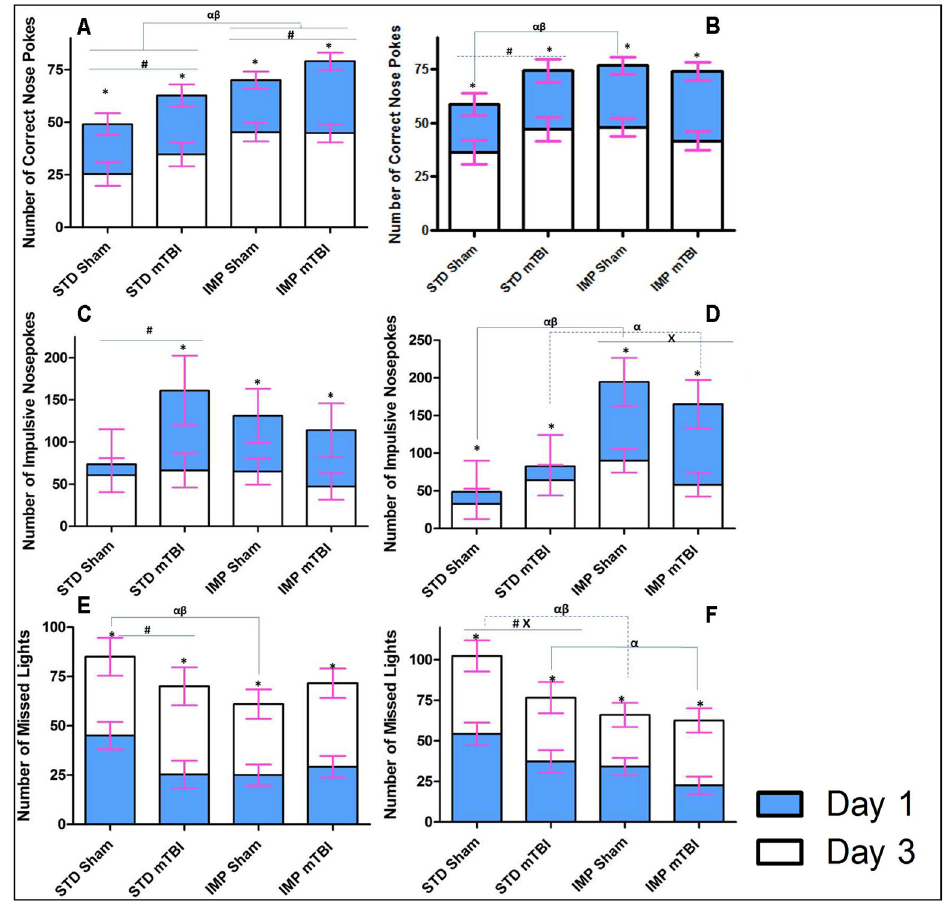
Fig 8. Illustrative representation of the results from the extinction portion of the behavioural testing for STD and IMP animals; blue bars represent the initial testing day and white bars represent the scores after the 3 rd consecutive day of no reward in the 5 choice serial reaction task. In this task, rats are no longer rewarded for completing the task as previously trained; therefore learning would entail switching strategies and reducing the number of correct nose pokes. The upper panels (A & B) demonstrate the number of correct lights with STD-shams learning the task quicker; the middle panels (C & D) show that the average number of impulsive nose-pokes (premature or inappropriate) decreased when the reward was removed; and finally (E & F) represent the number of lights that the rats chose to ignore with STD-shams again outperforming all other groups ( α significant effect of IMP at Day 1, β significant effect of IMP at Day 3, x significant effect of mTBI, * significant effect of testing period, all p <